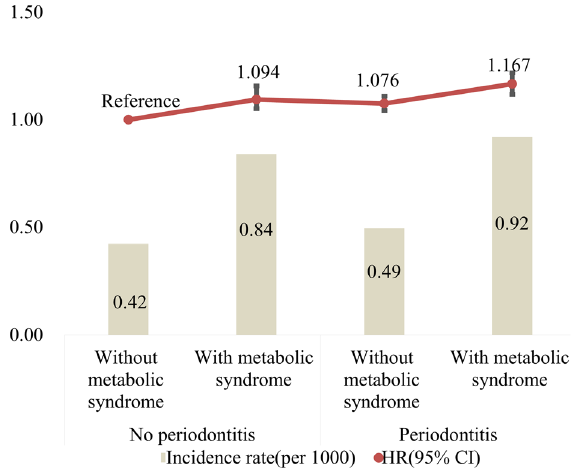
Figure 2. The combined effects of periodontitis and metabolic syndrome on incident Parkinson’s disease risk after adjusting for confounding factors. Periodontitis and metabolic syndrome had a significant interaction on the risk of Parkinson’s disease ( P for interaction <